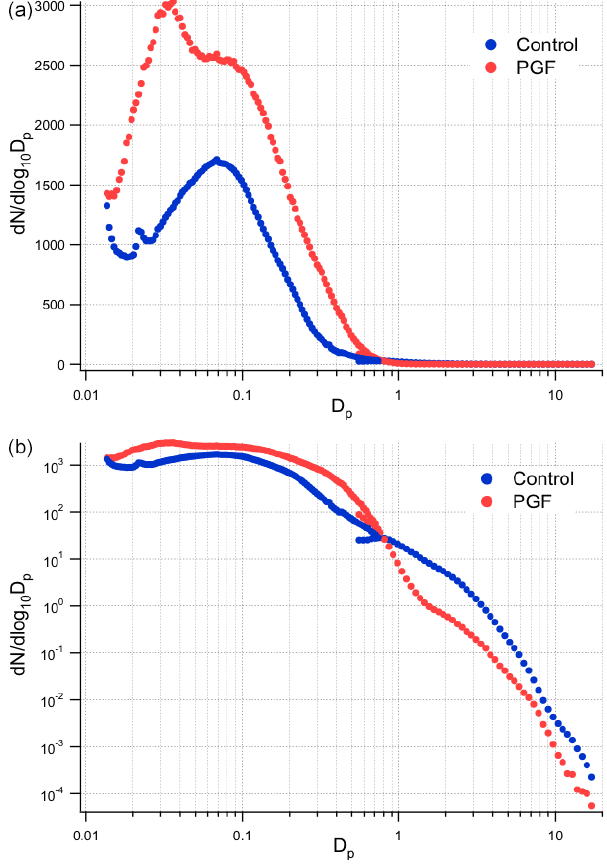
Figure 5. (a) Composite merged SMPS-APS size distribution dis- played as for PGF (red) and CTL (blue) periods. (b) As in (a) except displayed on a log